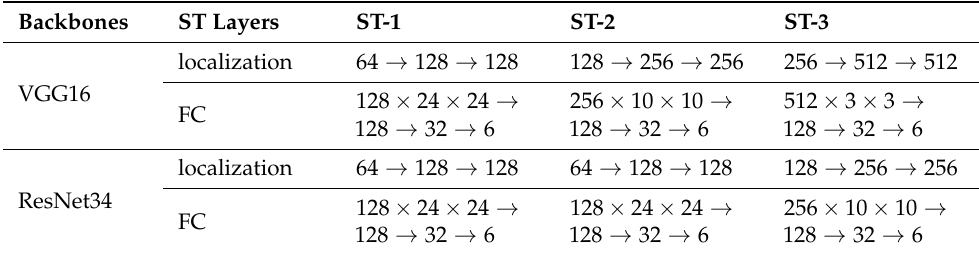
Table 1. Channels parameter setting for ST modules in VGG16 and